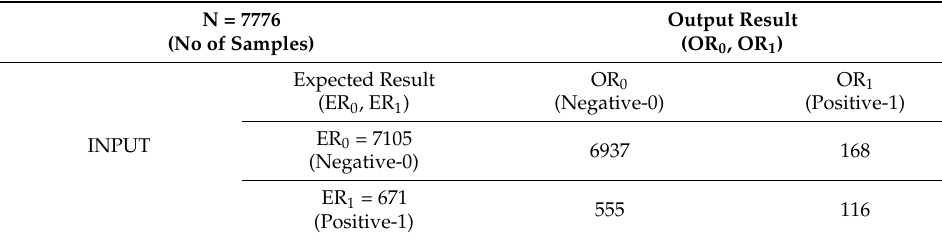
Table 7. Naïve Bayes testing